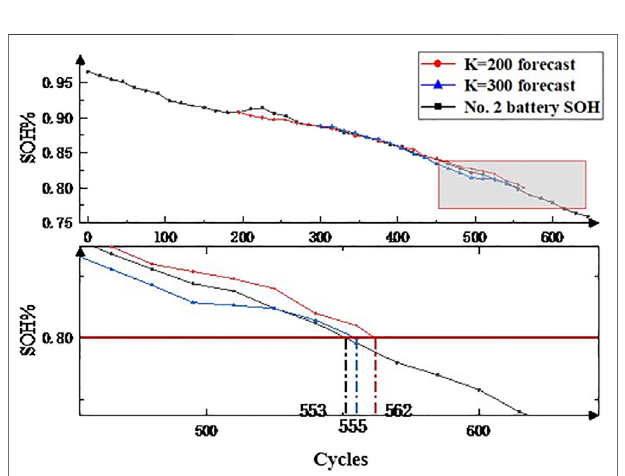
FIGURE 8 | Prediction results of the improved particle fi lter algorithm for No. 3 battery.